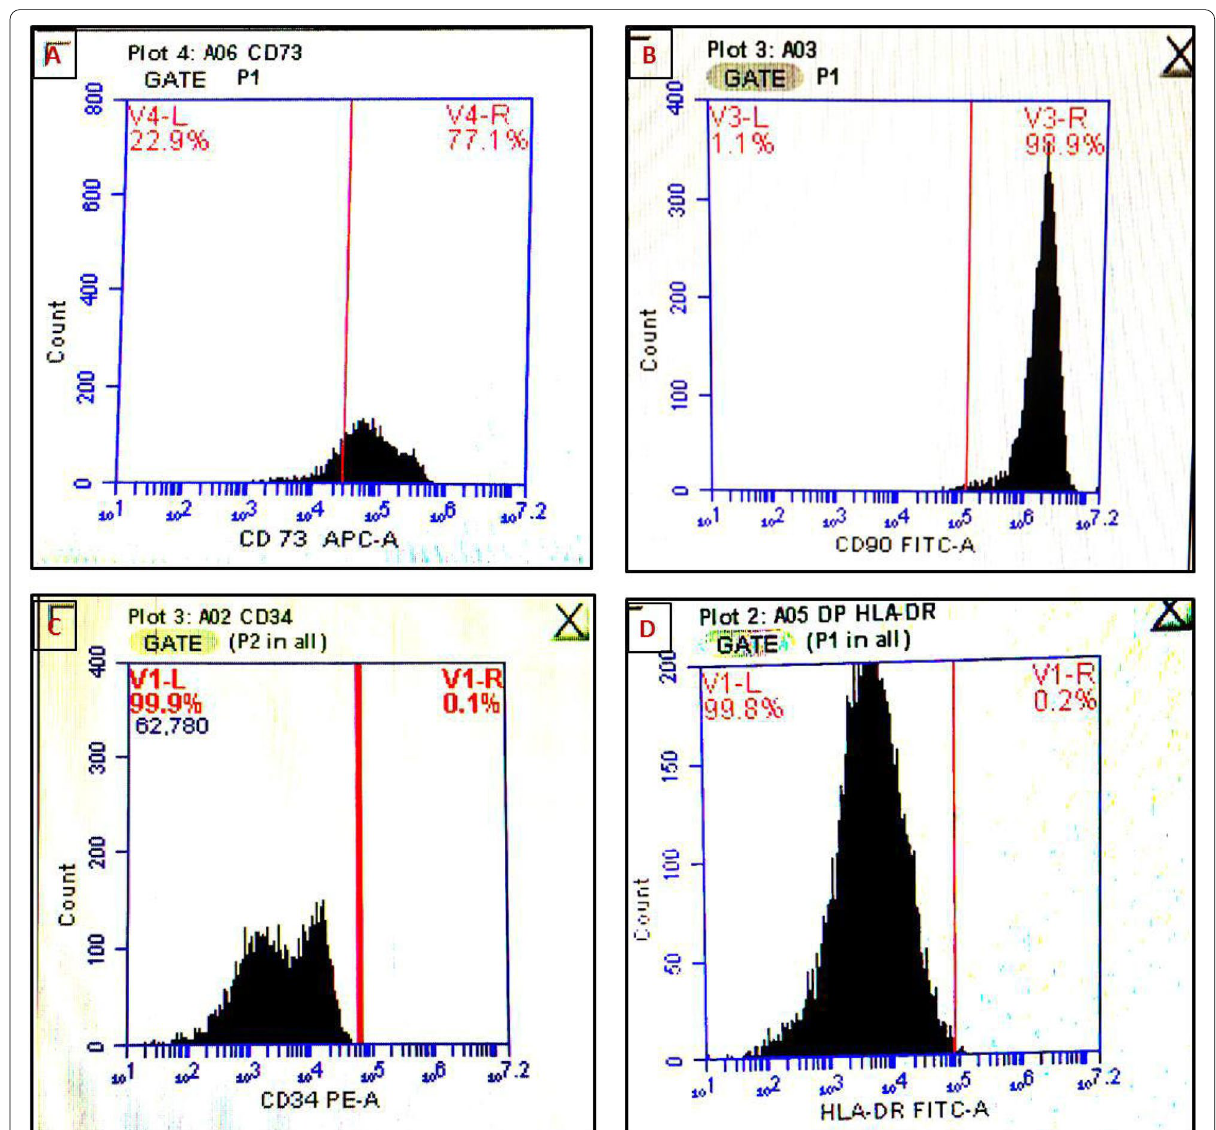
Fig. 3 Flow cytometric examinations of hDP‑MSCs. A and B hDP‑MSCs were 77.0% and 98.9% positive for both CD73 and CD90 cell surface markers, respectively. C and D hDP‑MSCs were 0.1% and 0.2% negative for both CD34 and HLA‑DR cell surface markers,